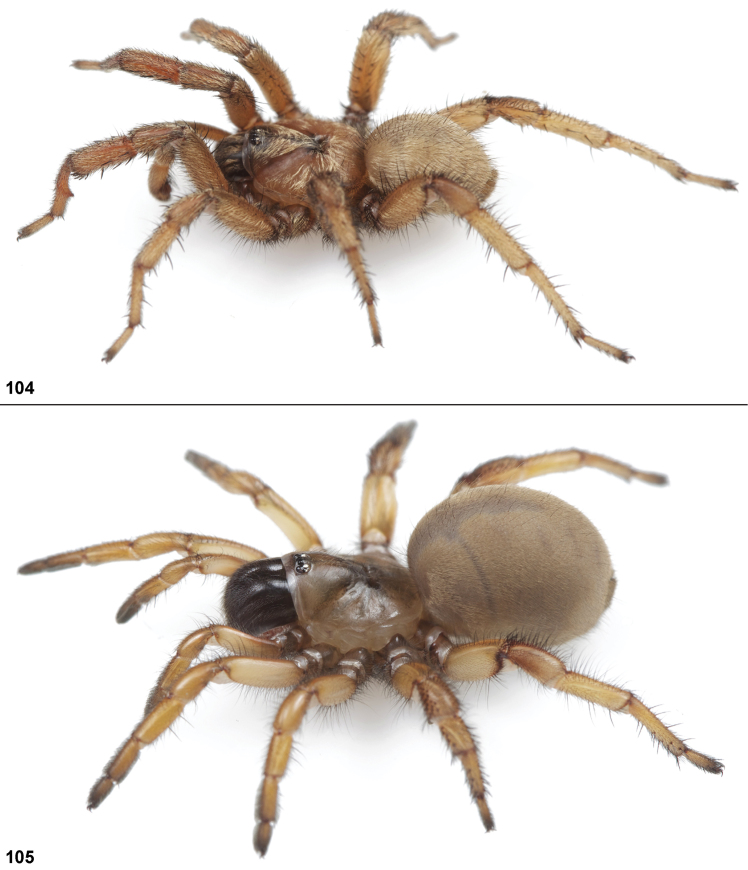
Aptostichus miwok from Mendocino Co., Inglenook Dunes area, live photographs. 104 male specimen (AUMS18) 105 female specimen (AUMS16).